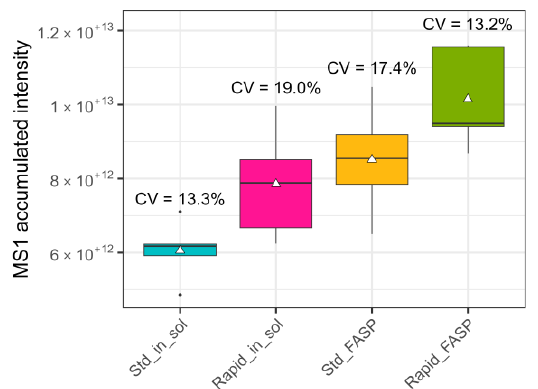
Figure 1. Raw data quality assessment: number of MS1 and MS2 spectra. CSF samples were digested using different approaches: Std_in_sol—standard in-solution digestion; Rapid_in_sol— rapid in-solution digestion; Std_FASP—standard filter-aided preparation; Rapid_FASP—rapid filter- aided preparation. Some 500 ng of the respective digestions were measured with nanoLC-MS and the acquired data were analyzed using our in-house developed quality control tool MaCProQC . ( a ) the number of precursor spectra and ( b ) number of fragment spectra as well as the coefficient of variation (CV) of these between replicates (n = 5) were analyzed. The highest variation in both the number of MS1 and MS2 spectra was observed for the rapid FASP; the lowest one for the rapid in-solution digestion.